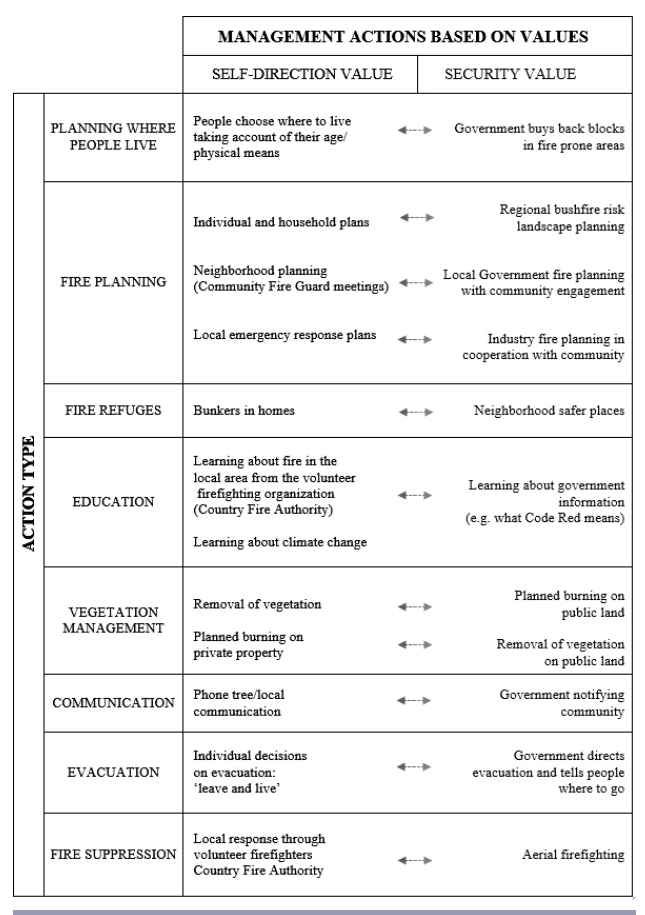
Fig. 4 . Organization of examples of management actions related to selected core values. The information in this table was gathered in workshop 1 and used in workshop